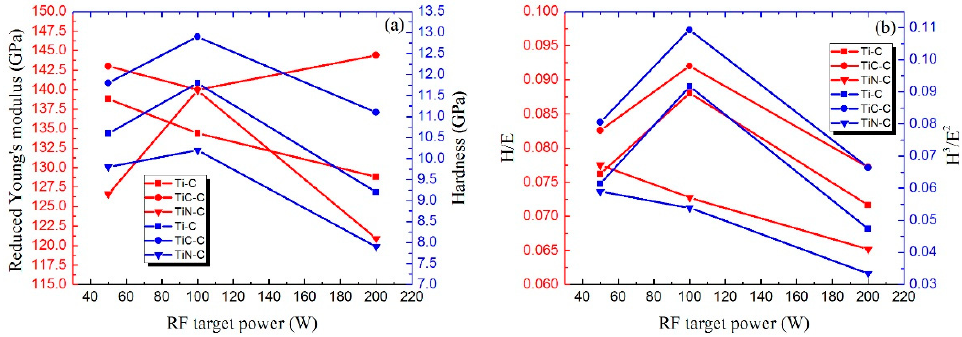
Figure 9. Mechanical properties of (Ti:N)-GLC films: ( a ) Hardness ( H ) and Reduced Young’s modulus ( E ); ( b ) H / E ratio and H 3 / E 2 ratio.